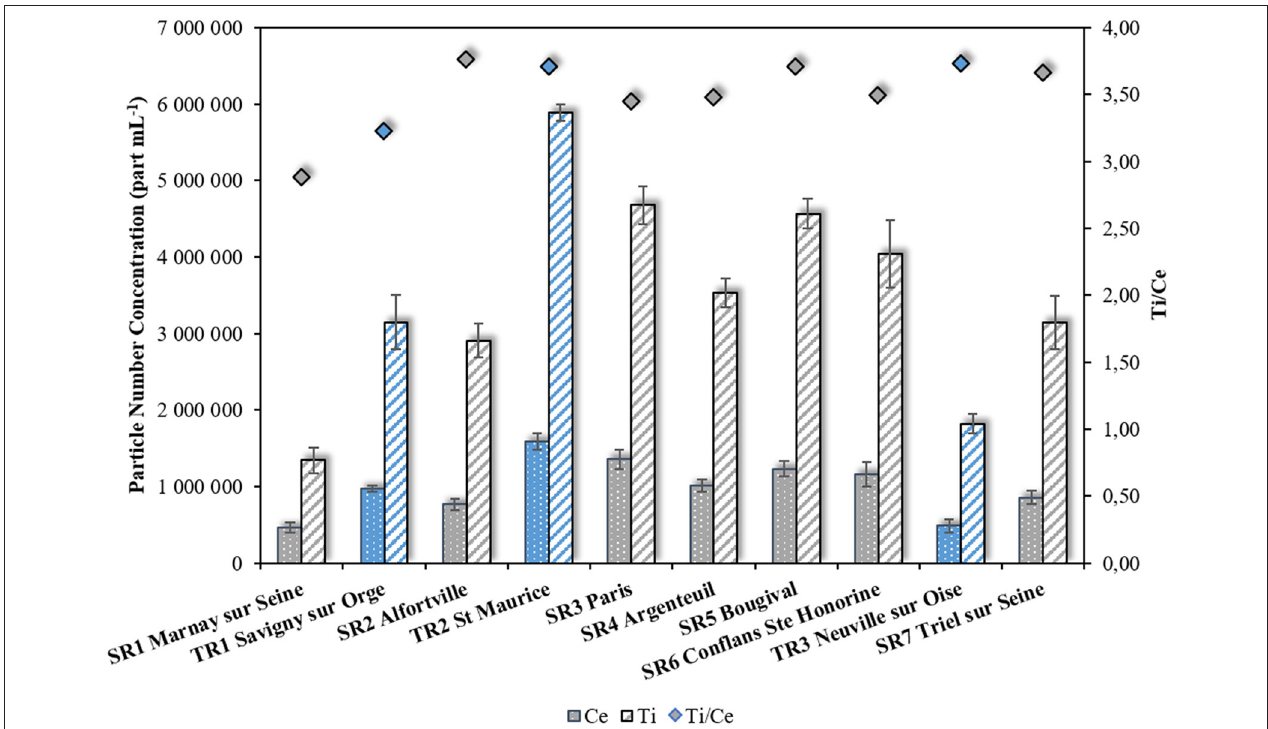
FIGURE 2 | Particle number concentration (left-hand side axis) determined by spICPMS for Ce- and Ti-bearing particles along the Seine River. In gray are the sampling points located in the Seine River and in red, in the tributaries. Also shown is the Ti/Ce particle number on the secondary y -axis.